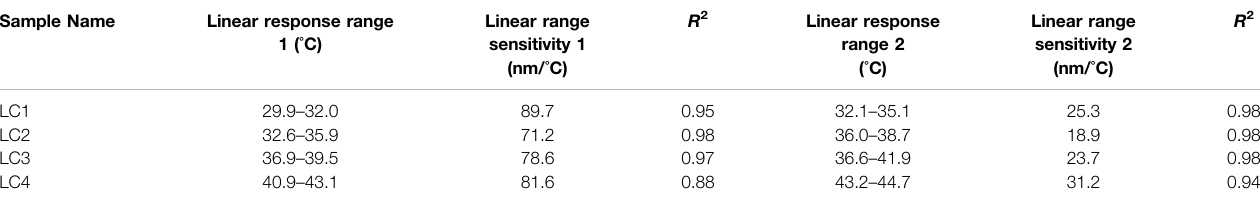
TABLE 2 | Liquid crystals response range and sensitivity. Measurement done using the